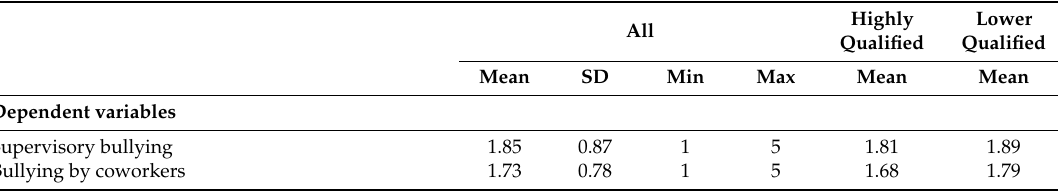
Table 1. Description of individual characteristics for all employees, as well as for employees with and without high school